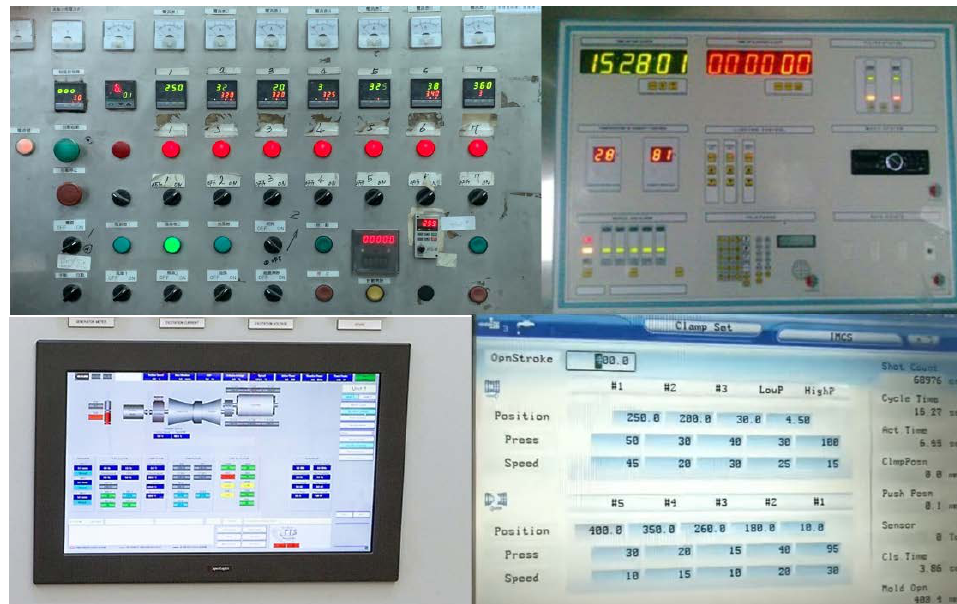
Figure 2. The operation control panel.